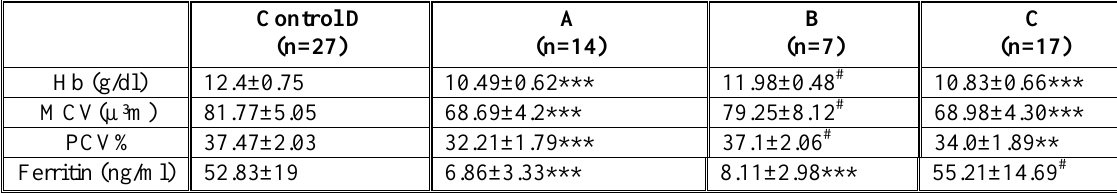
Table(5): Comparison of hematological parameters and serum ferritin level among children